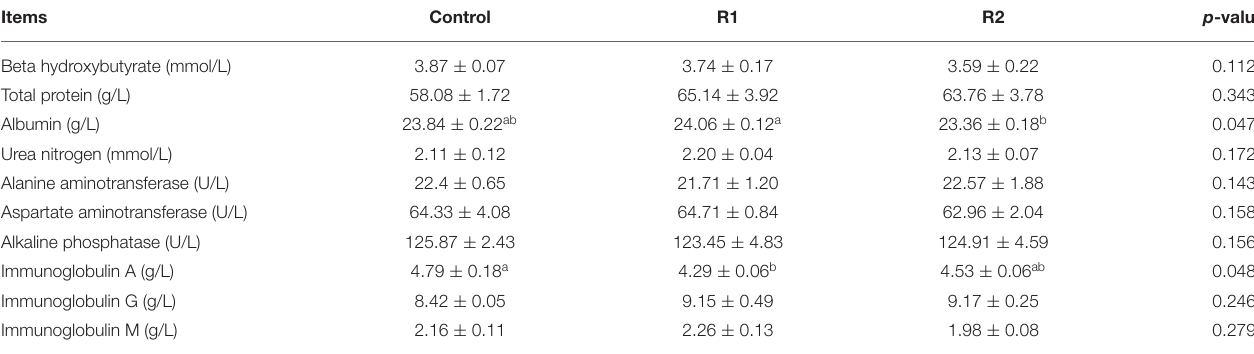
TABLE 5 | Effects of different dietary levels of fermented-Moutai distillers’ grain (FMDG) on the blood biochemical index of Guanling cattle.